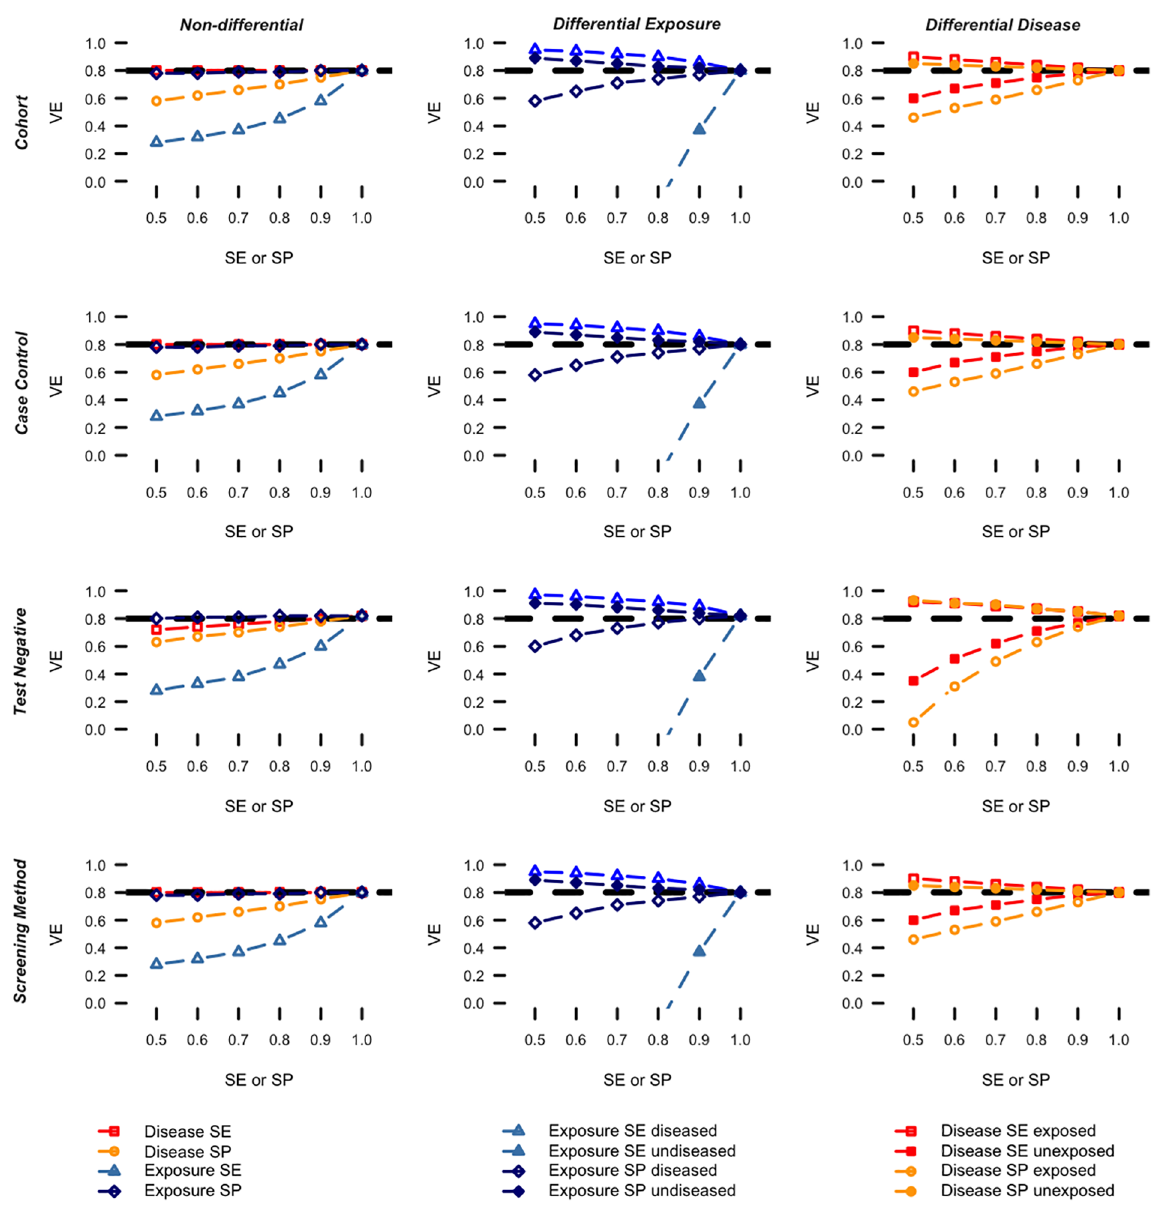
Fig 2. Pertussis scenario: Vaccine effectiveness by design for varying levels of exposure- and disease misclassification while fixing the remaining parameters to 1. The dashed horizontal lines indicate the true VE used to simulate the data.